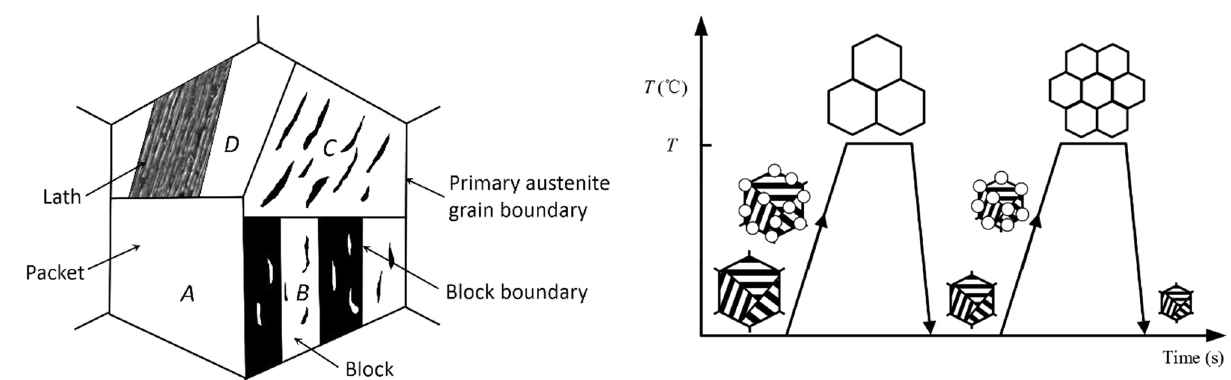
Figure 3: The mechanism of CHT